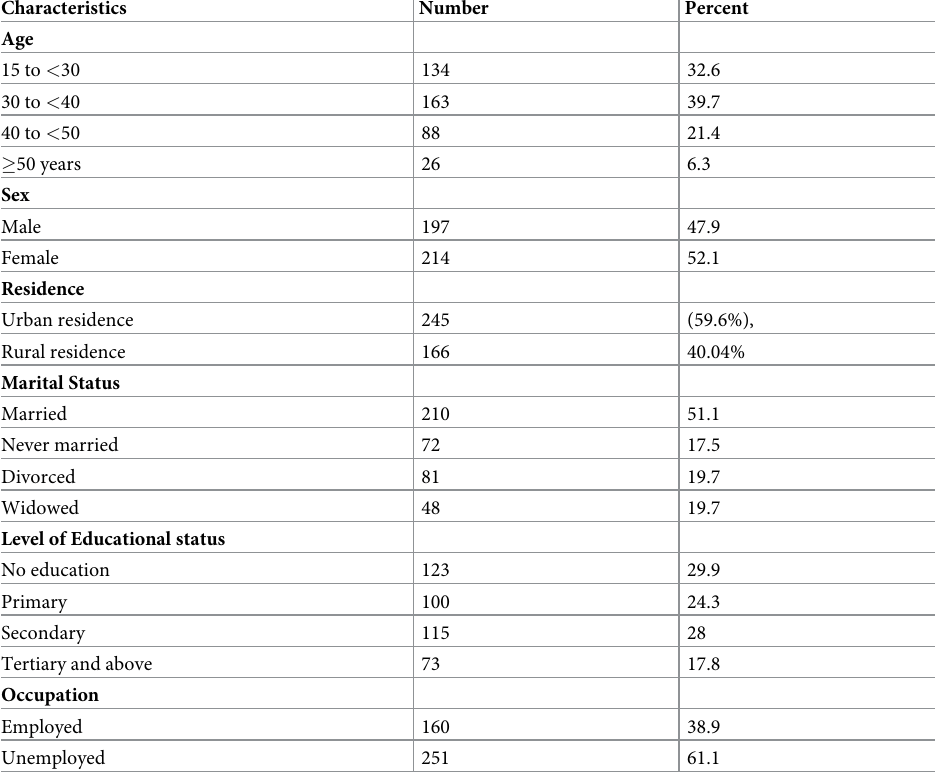
Table 1. Baseline socio demographic characteristics of adults on HIV care.